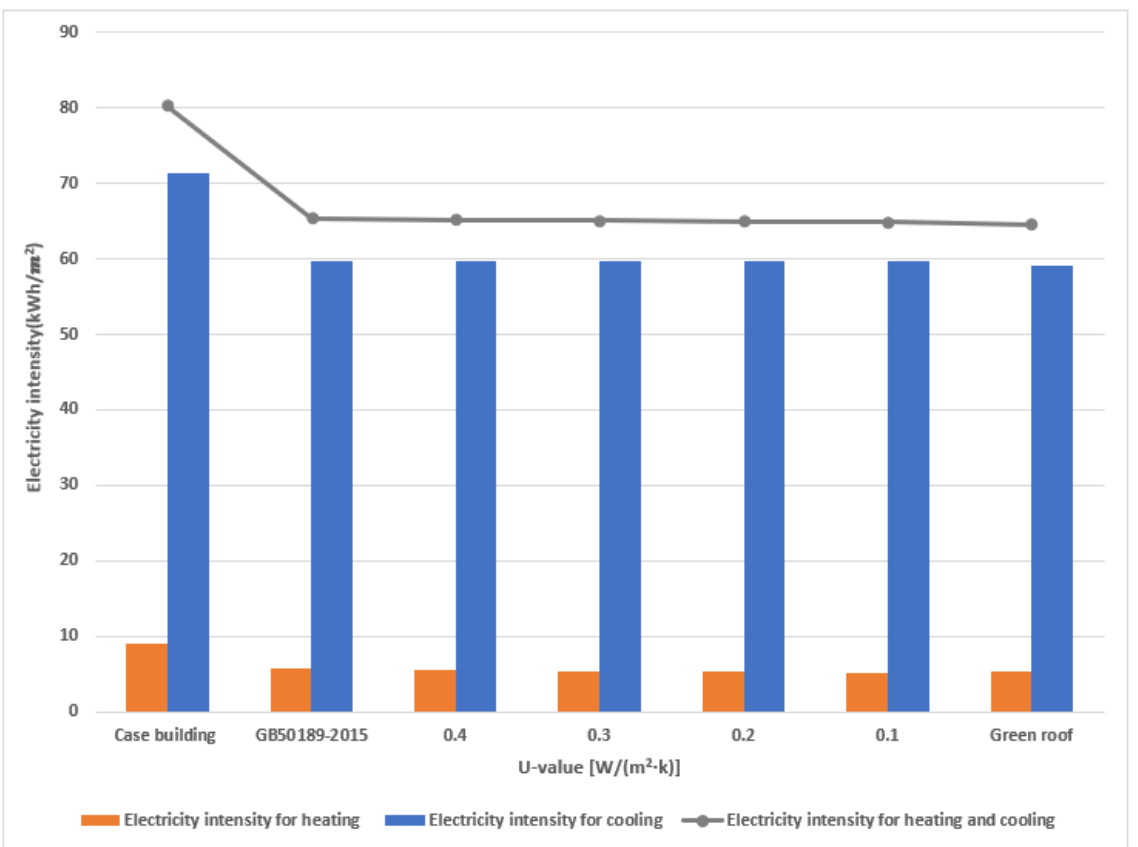
Figure 7. Electricity intensity for heating and cooling using different U-values for roof energy retro-fitting.